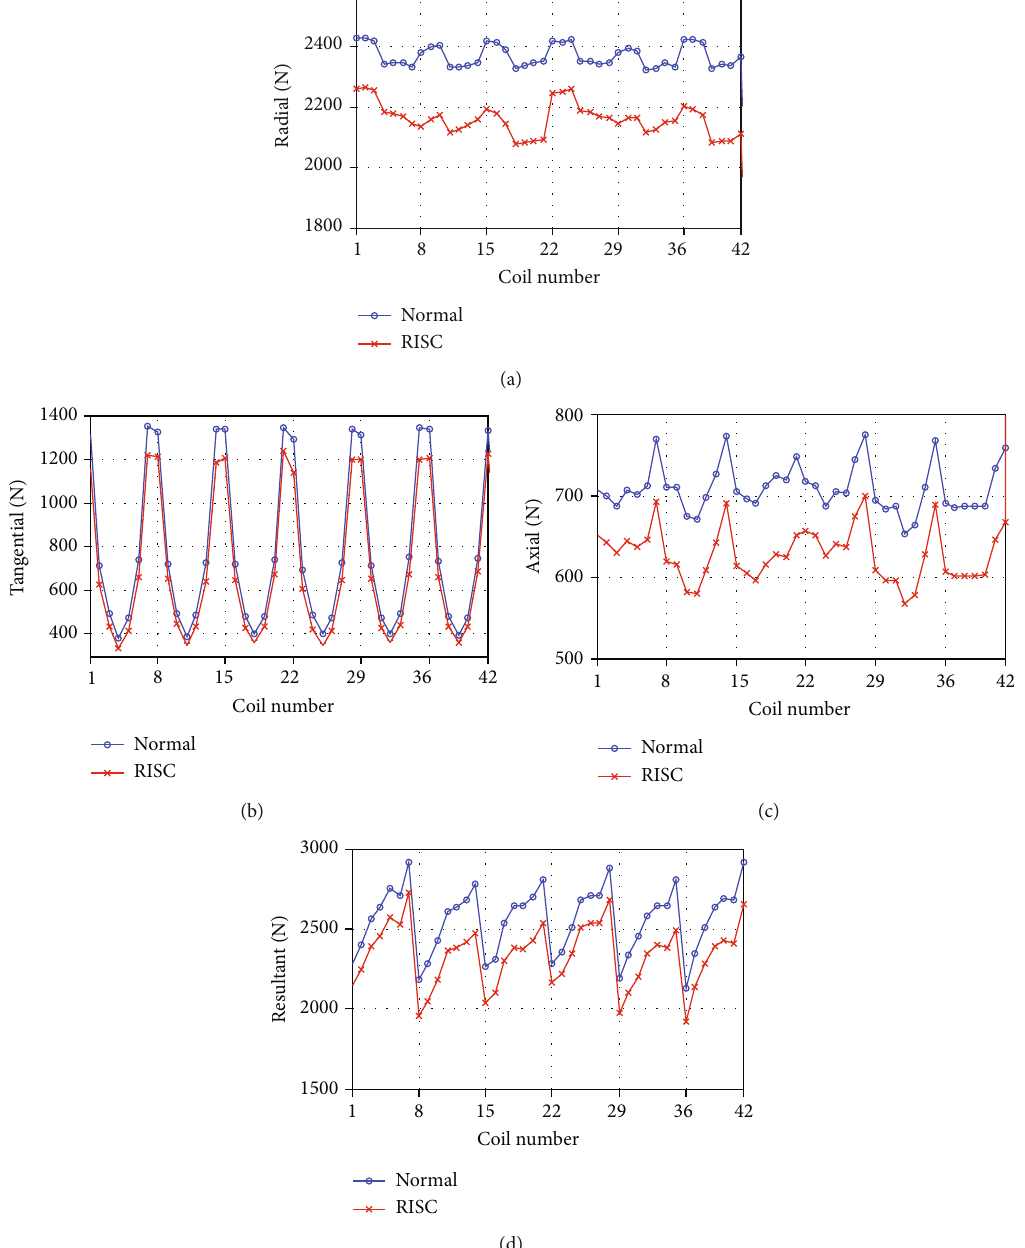
Figure 9: Second harmonic amplitude of electromagnetic force: (a) radial direction, (b) tangential direction, (c) axial direction, and (d) resultant